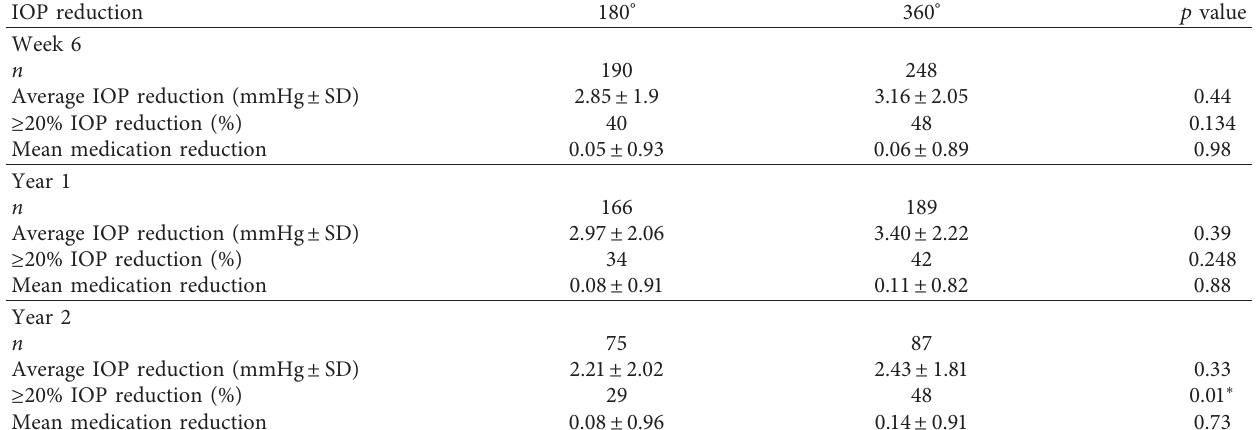
Table 3: Comparison of average IOP reductions between the 180 ° and 360 ° SLT